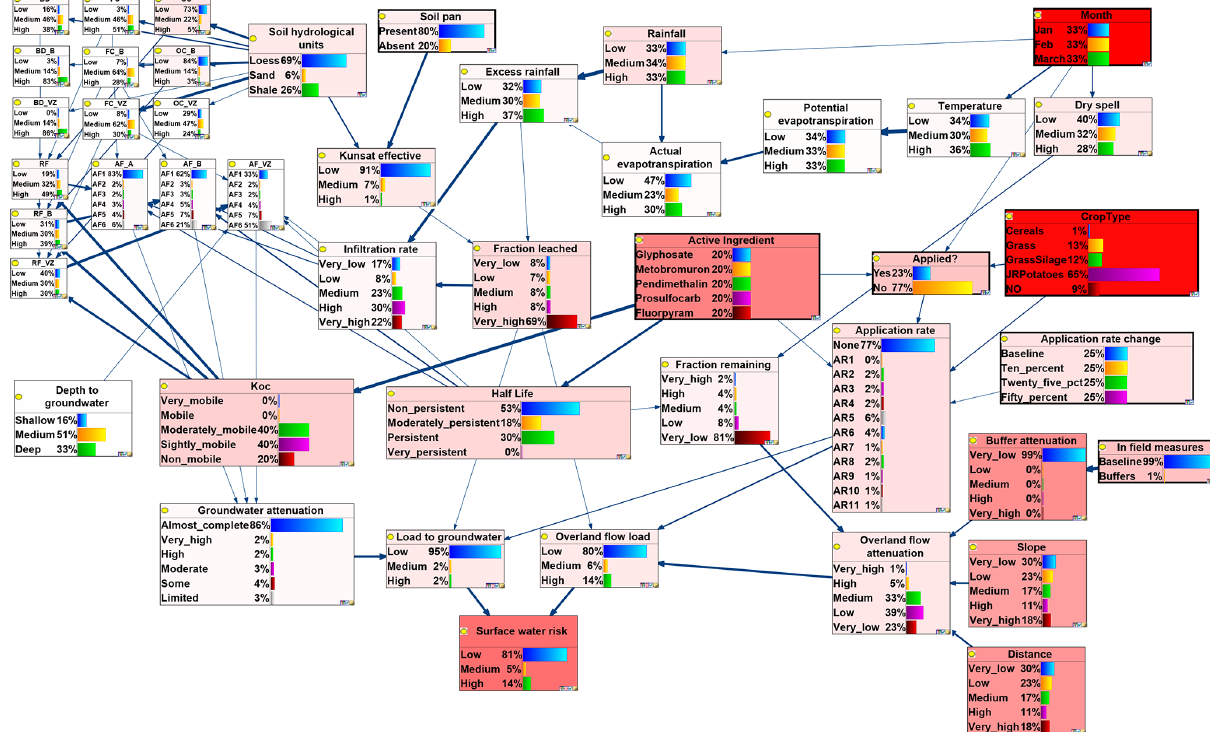
Figure 7. Strength of influence and sensitivity analysis implemented in the discrete version of the network (Kjærulff and van der Gaag, 2000) using surface water risk, groundwater load, and overland flow load as target nodes. Deeper red colouring shows the more influential variables. The thickness of the arrows indicates the strength of the influence between two directly connected nodes calculated as the Euclidean distance. Table 3. Strength of influence for the top 20 most closely related variables (Euclidean distance > 0 . 5). The abbreviations used in the table are as follows: RF – retardation factor, AF – attenuation factor, VZ – vadose zone, and B – soil horizon